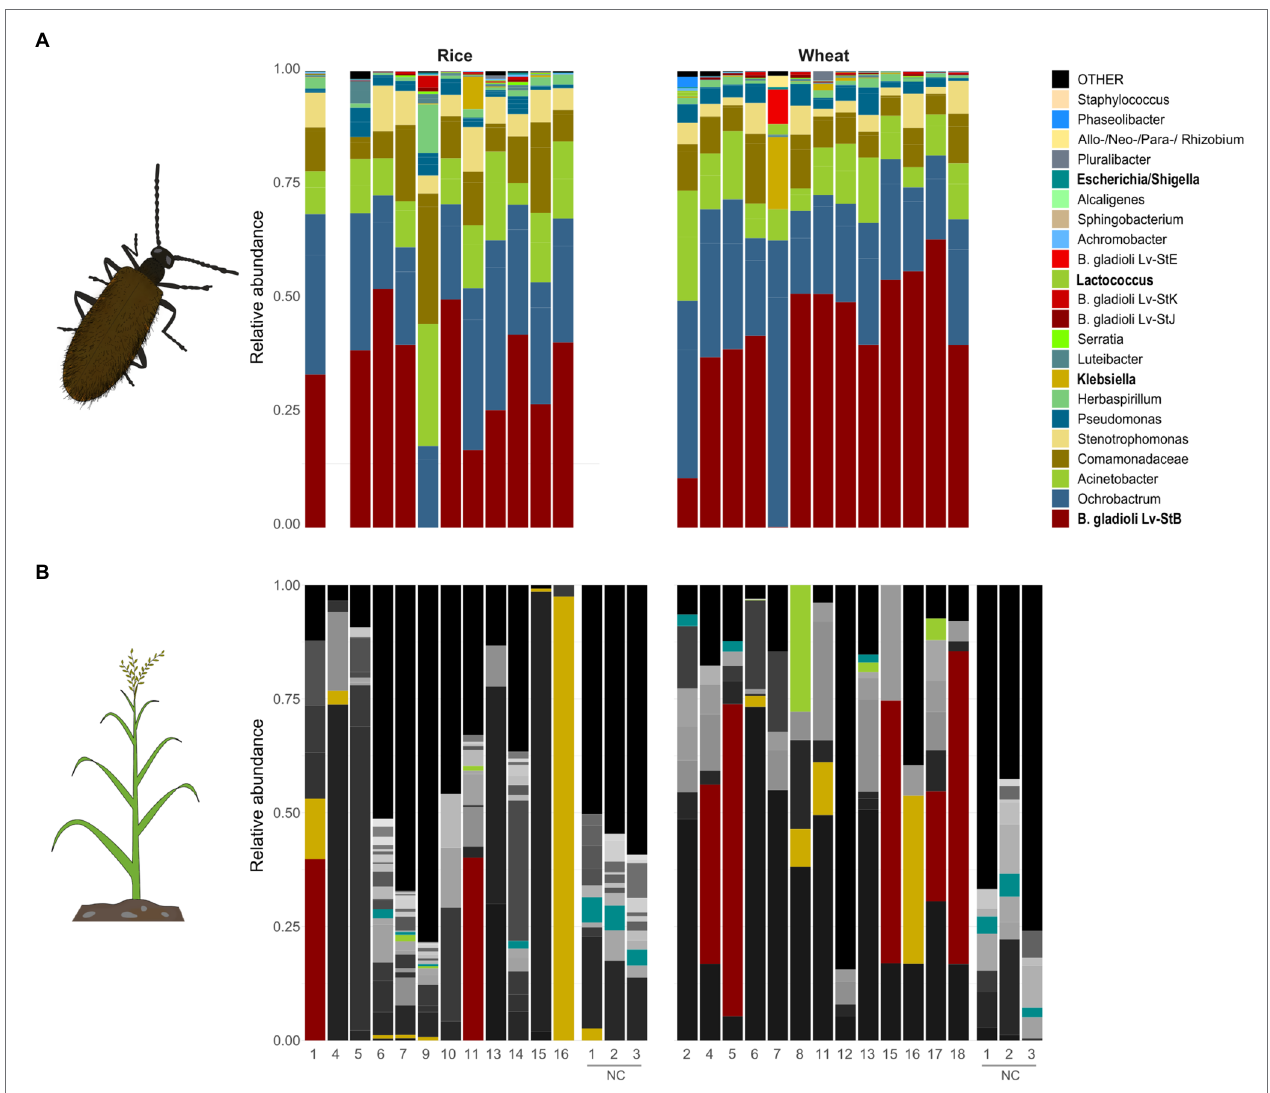
FIGURE 2 | Bacterial community composition in (A) glands of L. villosa beetles and (B) plant tissue that was exposed to the corresponding beetles, excluding samples that did not meet the threshold after chloroplast sequence removal. The relative abundance of bacterial amplicon sequence variants (ASVs) assessed at genus level by DADA2 analysis on the V4 region of the 16S rRNA gene is represented. Only the 30 most abundant bacterial ASVs for each corresponding sample type (glands or plants) are shown, and the remaining ASVs are grouped as “OTHER.” Beetle-associated ASVs are highlighted in color, and ASVs only associated to plants are depicted in grey. Genera names highlighted in bold correspond to identical ASVs in both gland and plant samples. NC = Negative control pools from plants that were not exposed to